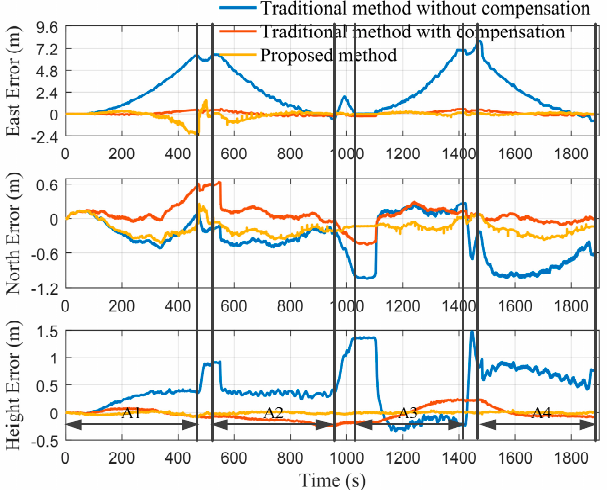
Figure 16. Comparison of positioning errors between the proposed method and the traditional method. Table 3. SEP in each cutting cycle.